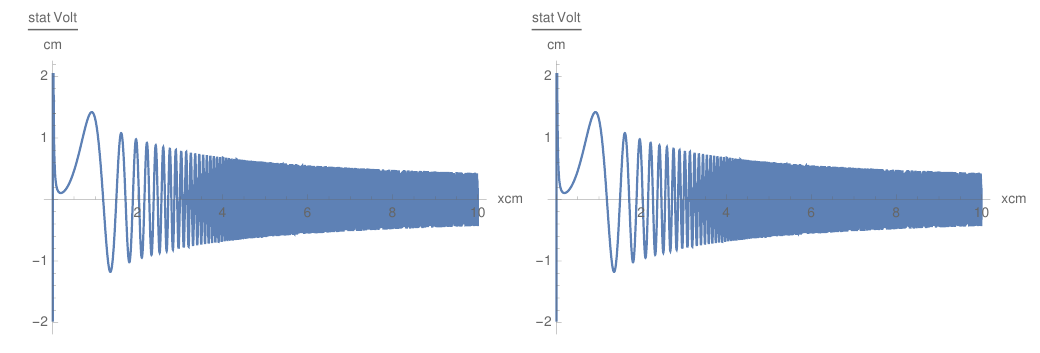
Figure 8. E x ( x , z , ω ) as a function of x for some values of z and ω : ω = 1.6 × 10 9 Hz and z = − 2 cm ( left ), and ω = 1.6 × 10 9 Hz and z = 2 cm ( right ).